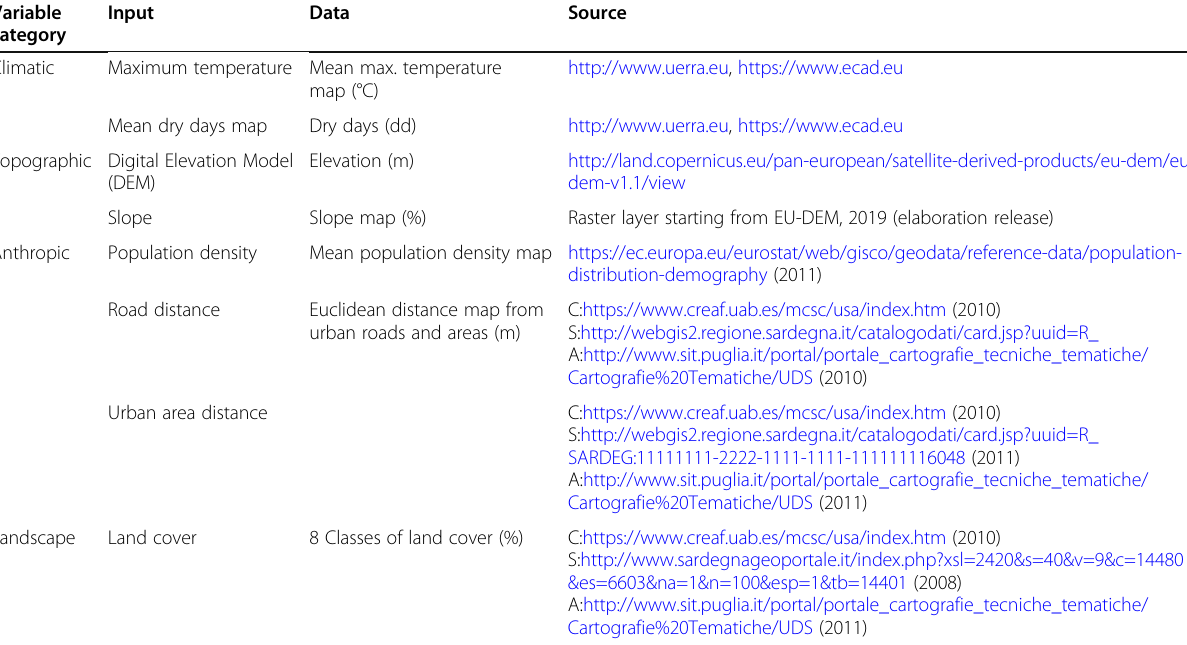
Table 1 Independent climatic, topographic, anthropic, and landscape variables used for the Hurdle models and as a source for each variable for the three study